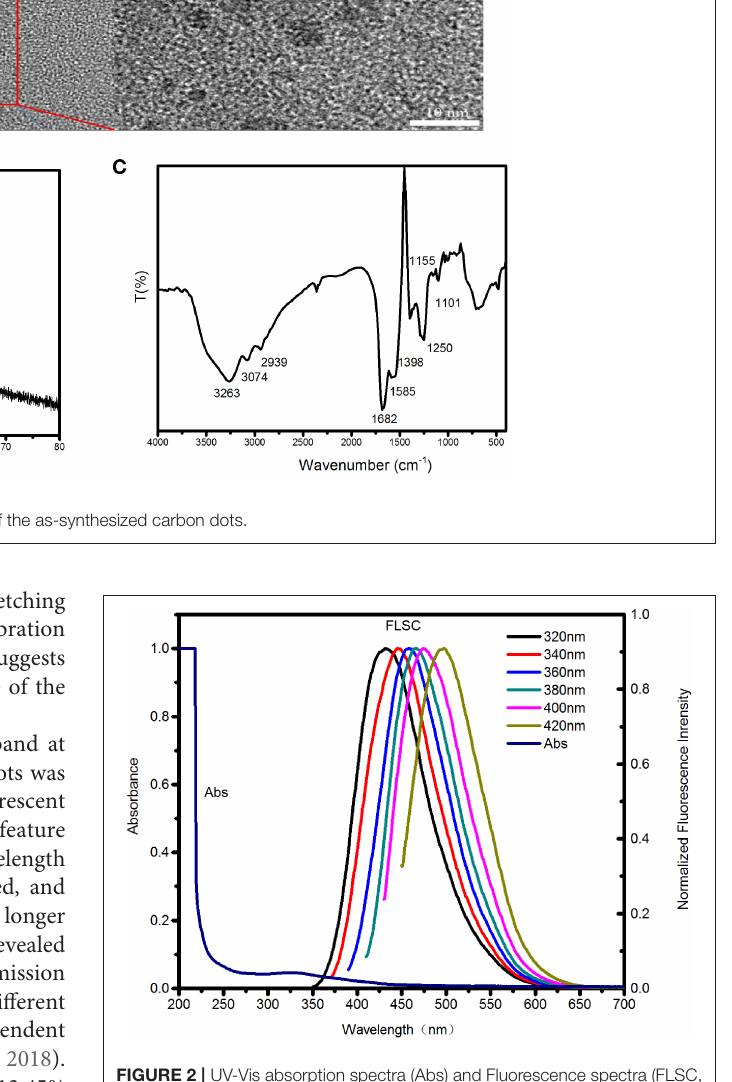
FIGURE 2 | UV-Vis absorption spectra (Abs) and Fluorescence spectra (FLSC, excitation wavelengths as indicated) of the as-synthesized C-dots in aqueous